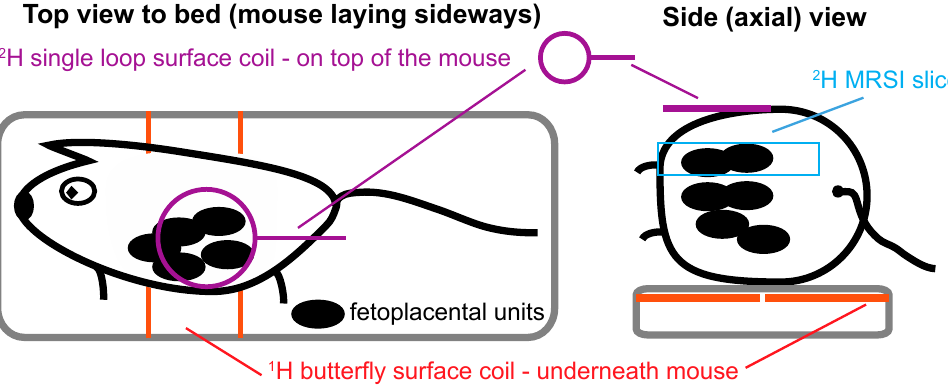
Figure 6. Cartoon depicting the layout used in the experiments described in this study; the 1 H butterfly coil is embedded in the bed itself.